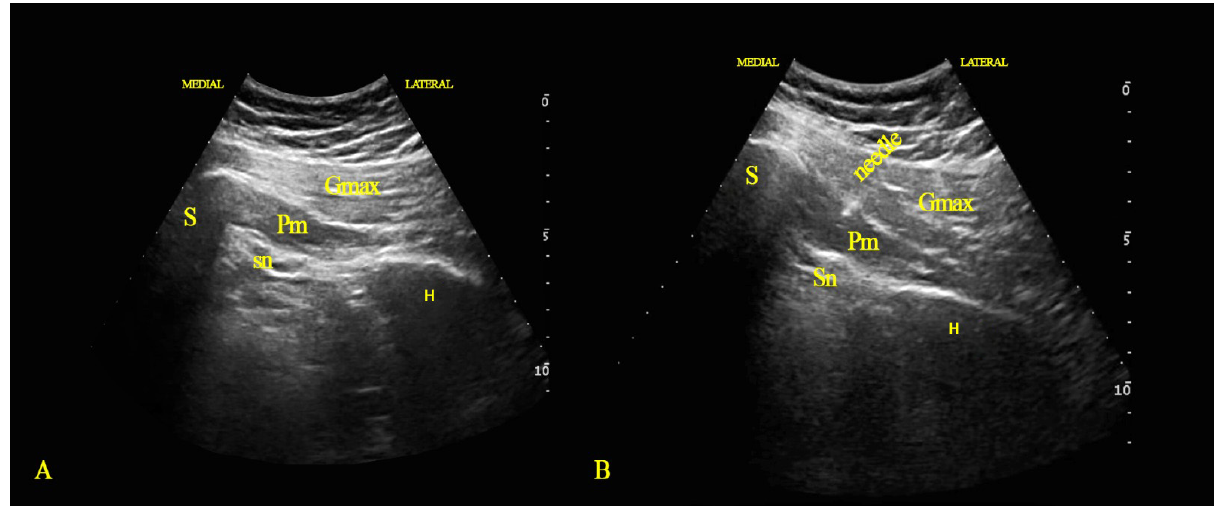
Figure 1. Ultrasound scan ( A ) and ultrasound-guided injection ( B ) for piriformis syndrome. S: sacrum; H: hip bone; G Max: gluteus maximus muscle; Pm: piriformis muscle; Sn: sciatic